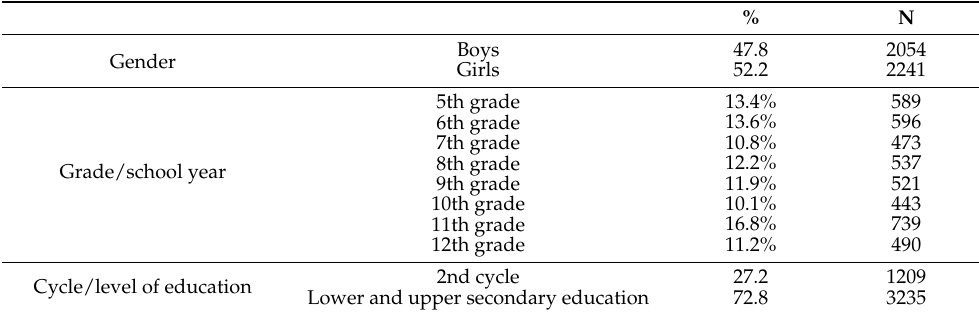
Table 1. Distribution of participants by gender, grade/school year and cycle/level of education: frequencies and percentages.